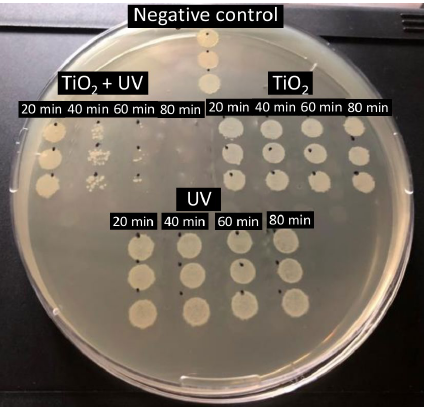
Fig. 2 The ability of E. coli to form colonies assayed by DP method. Obtained results after overnight incubation at 37 °C.